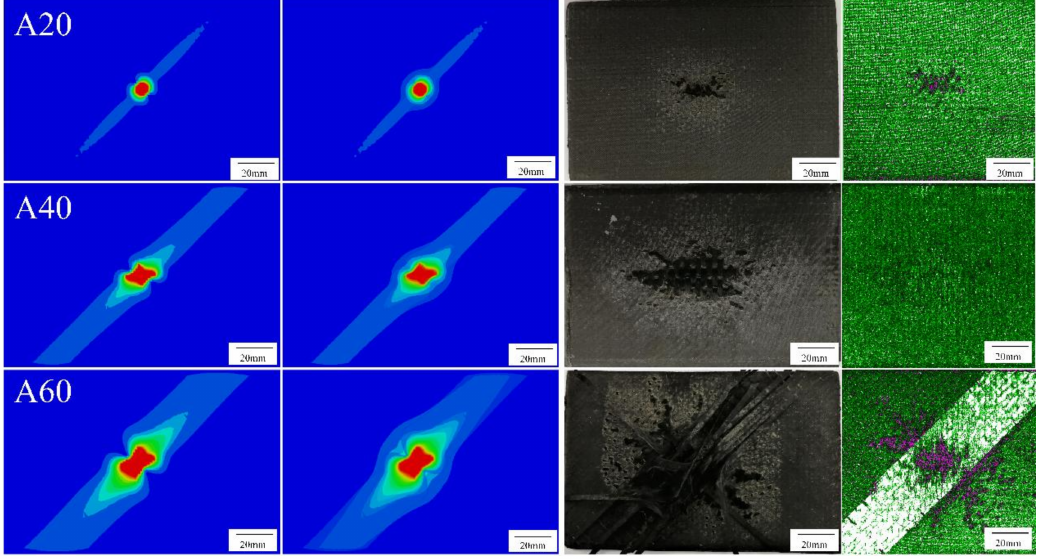
Figure 11. Results of Group A. Surface temperature field images of FEA, surface–subsurface superimposed temperature field images of FEA, specimen photos, and their ultrasonic C-scan images are shown from left to